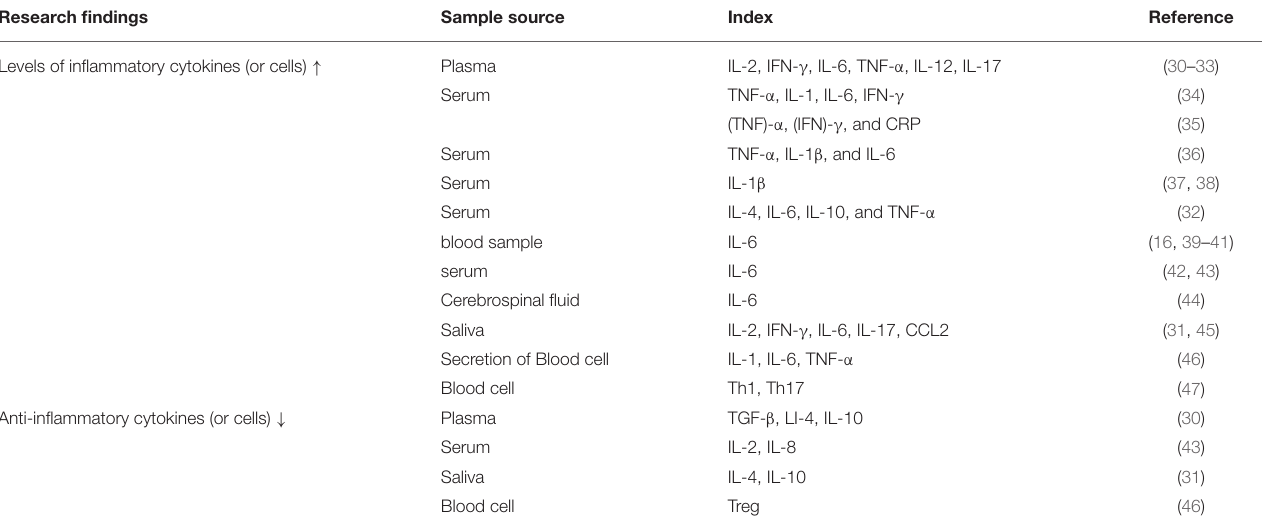
TABLE 1 | Summary of literature reporting inflammatory cytokine changes in PTSD patients. Research